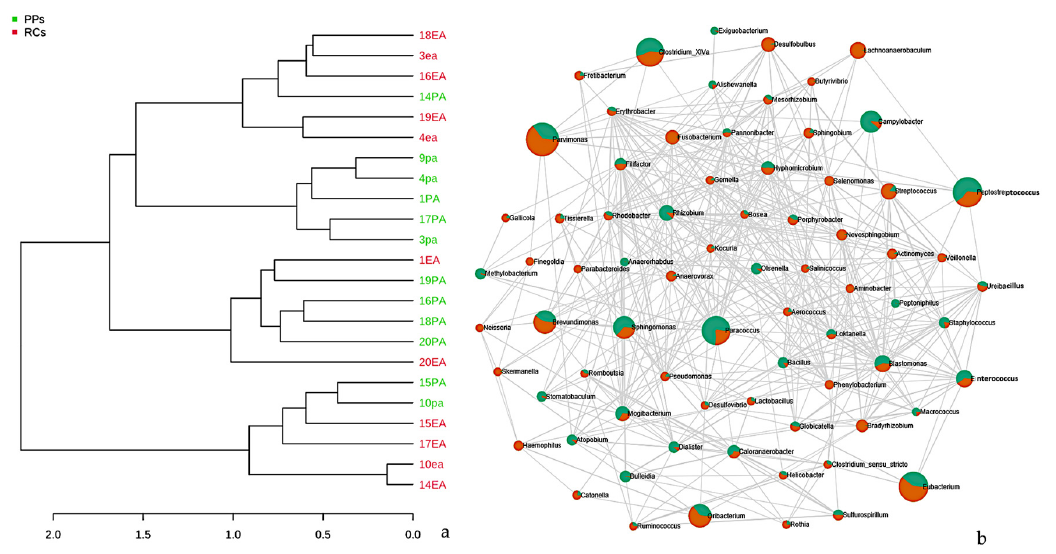
Figure 7. ( a ) Dendrogram showing the similarities between the samples of RCs and PPs. The dendrogram was created using the Jaccard index as a distance measure and Ward’s clustering algorithm considering a 1000-repetition bootstrap. ( b ) Correlation and co-occurrence analysis of cases of root canals (green) and periodontal pockets (orange) genera. The interactions (connections) represent the relationship (Spearman’s (cid:36) > 0.6) and the significance ( p < 0.01). Circles represent the relative abundance of each condition of study; the thickness of each connection between two nodes is proportional to the value of Spearman’s correlation coefficients.3.4. Metabolic prediction in RCs and